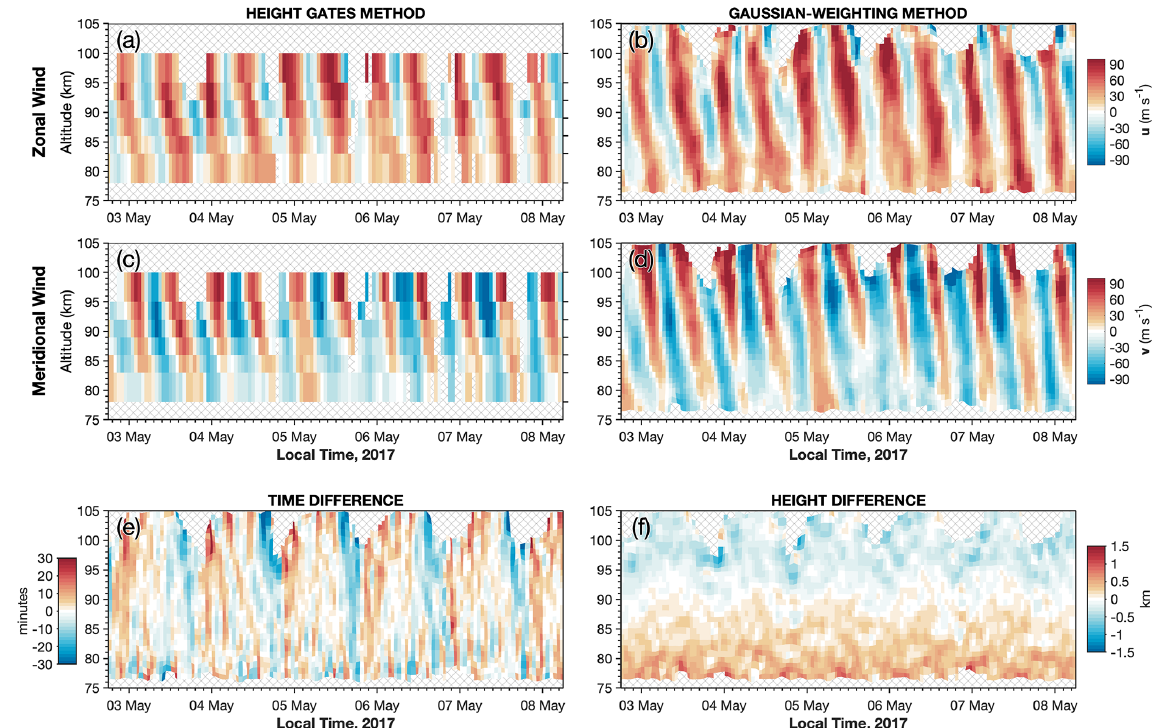
Figure 2. Derived zonal and meridional winds from the South Georgia meteor radar during May 2017 using (a, c) a traditional time–height binning approach and (b, d) the new Gaussian time–height weighting approach described here. Hatched areas show regions with too few meteors to reliably derive winds. Lower panels (e) and (f) show differences between the Gaussian-weighted mean time and height of each derived wind measurement using the new method and the time and height at the centre of the weighting function (as would be used in a traditional binning